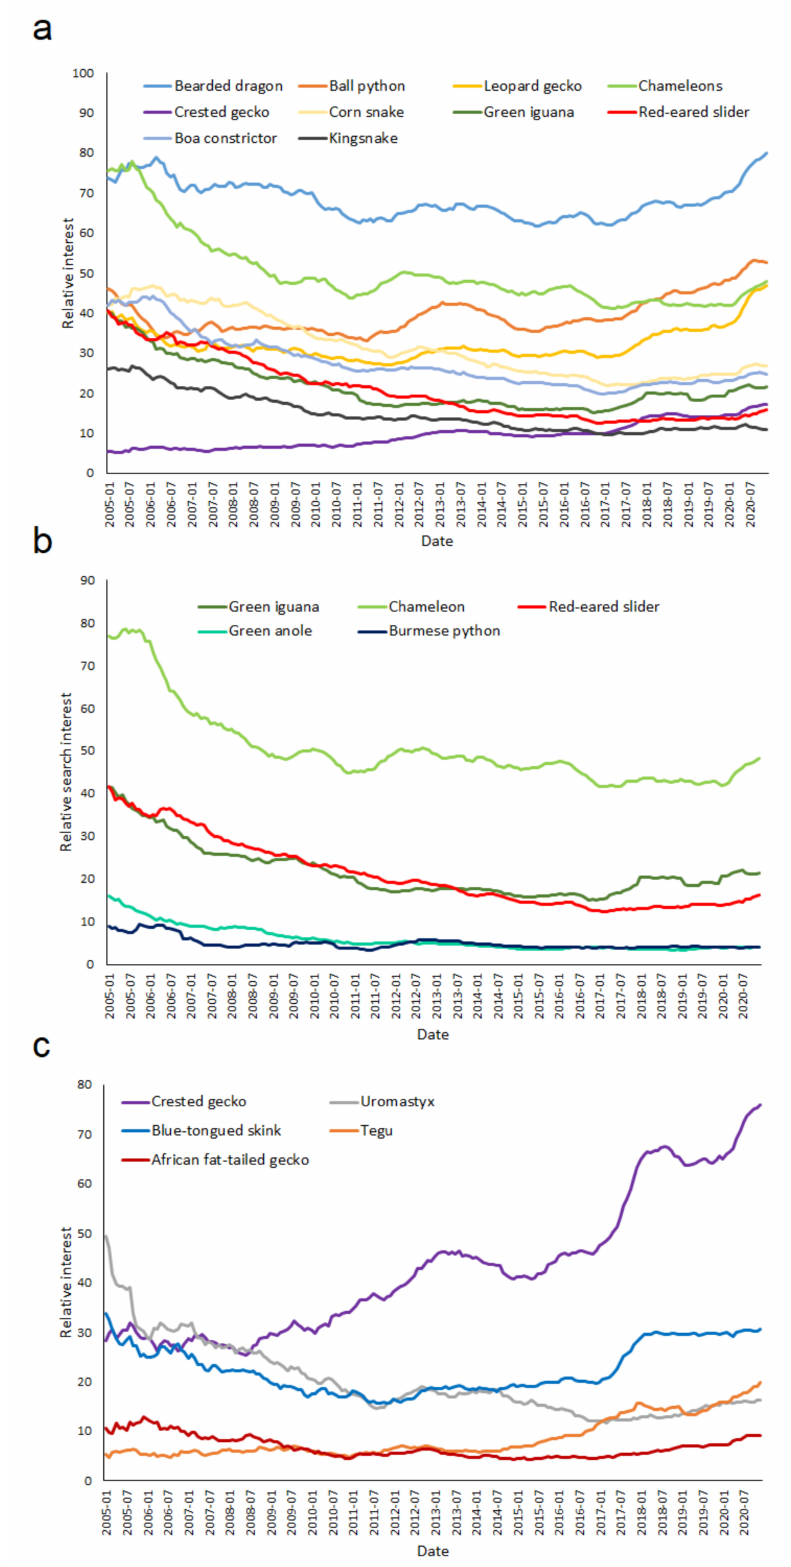
Figure 2. The ( a ) top ten most searched reptiles on Google, as well as the reptiles thought to ( b ) have lost most popularity in the previous decades and ( c ) will be much more popular in the next five to ten years, based on survey results. The numbers represent the yearly moving average search interest of reptiles relative to the highest point on the chart for the given date, with a value of 100 representing the peak popularity for a search term and a value of 50 indicating the term is half as